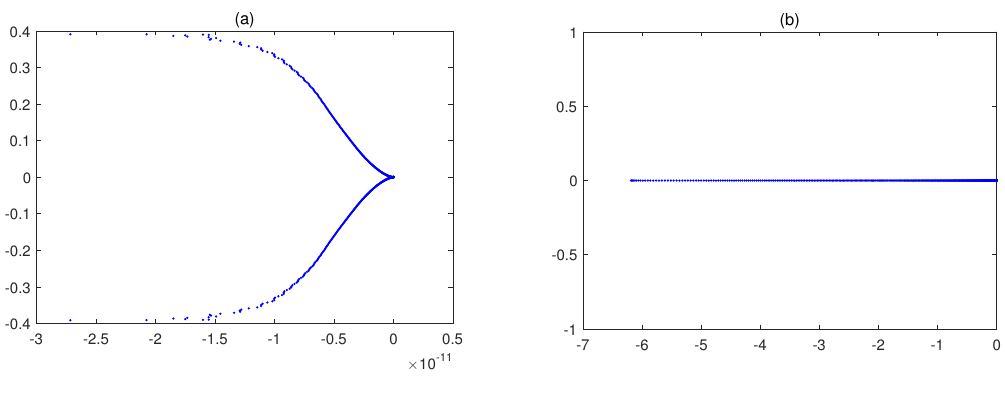
Figure 10. The eigenvalues of A ( a ) and B ( b ) for N = 5600, n i = 431 and c = 1.14 for Example